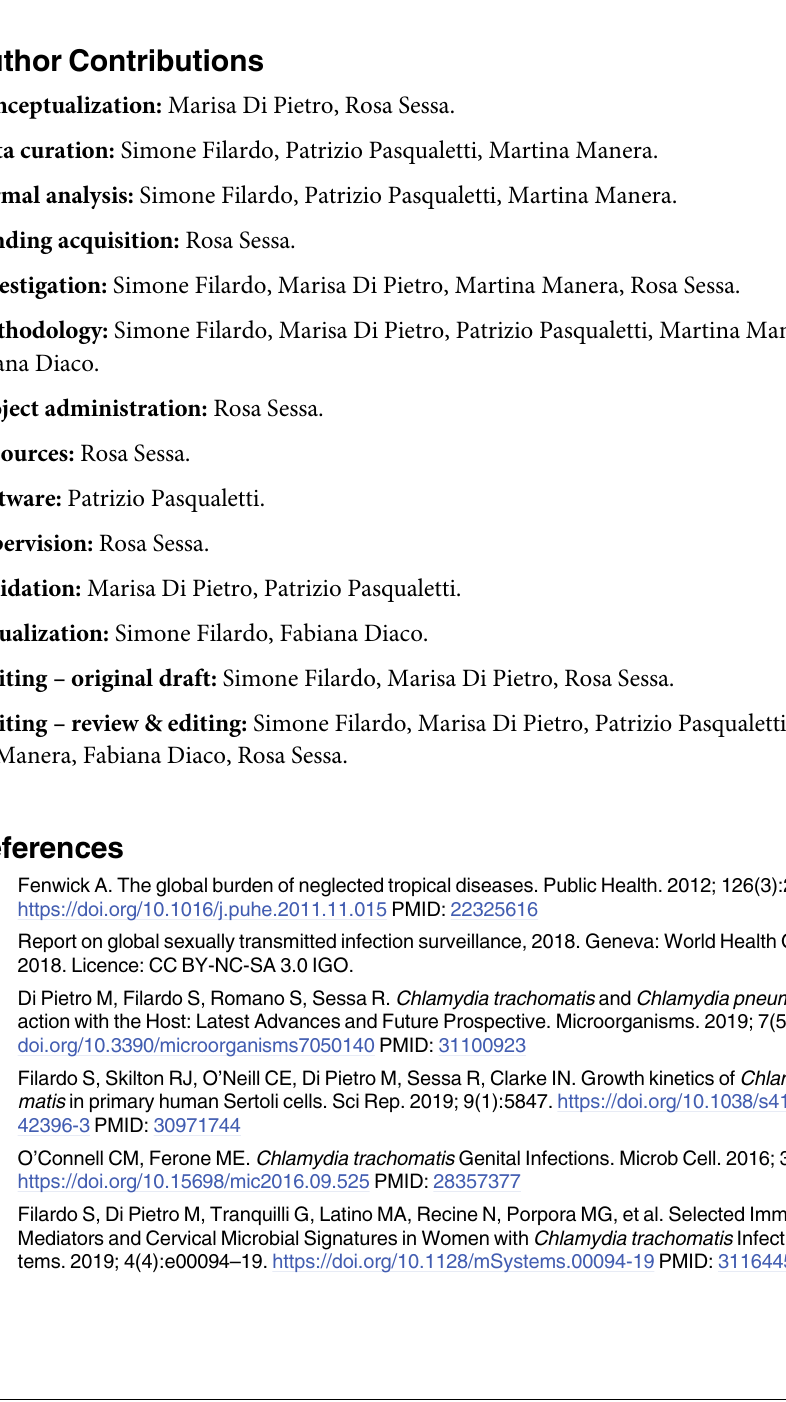
S1 Fig. Stability of IRdye 680RD after 1 month of storage at -20˚C. Absorbance values (AU) in relation to C. trachomatis MOI determined by Odyssey CLx in optically clear bottom and standard microplates scanned at day O and after 1 month of storage at